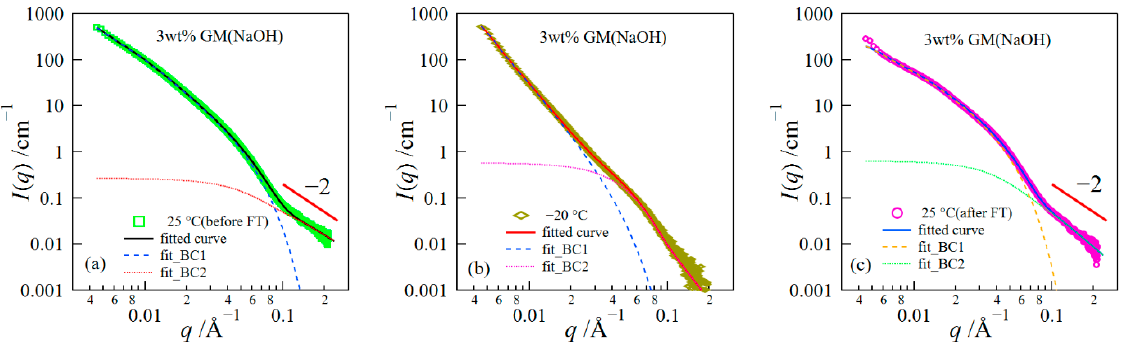
Figure 6. Comparison between SAXS data and fitted curves: ( a ) the structure before freezing, ( b ) the structure during freezing, and ( c ) the structure after thawing.